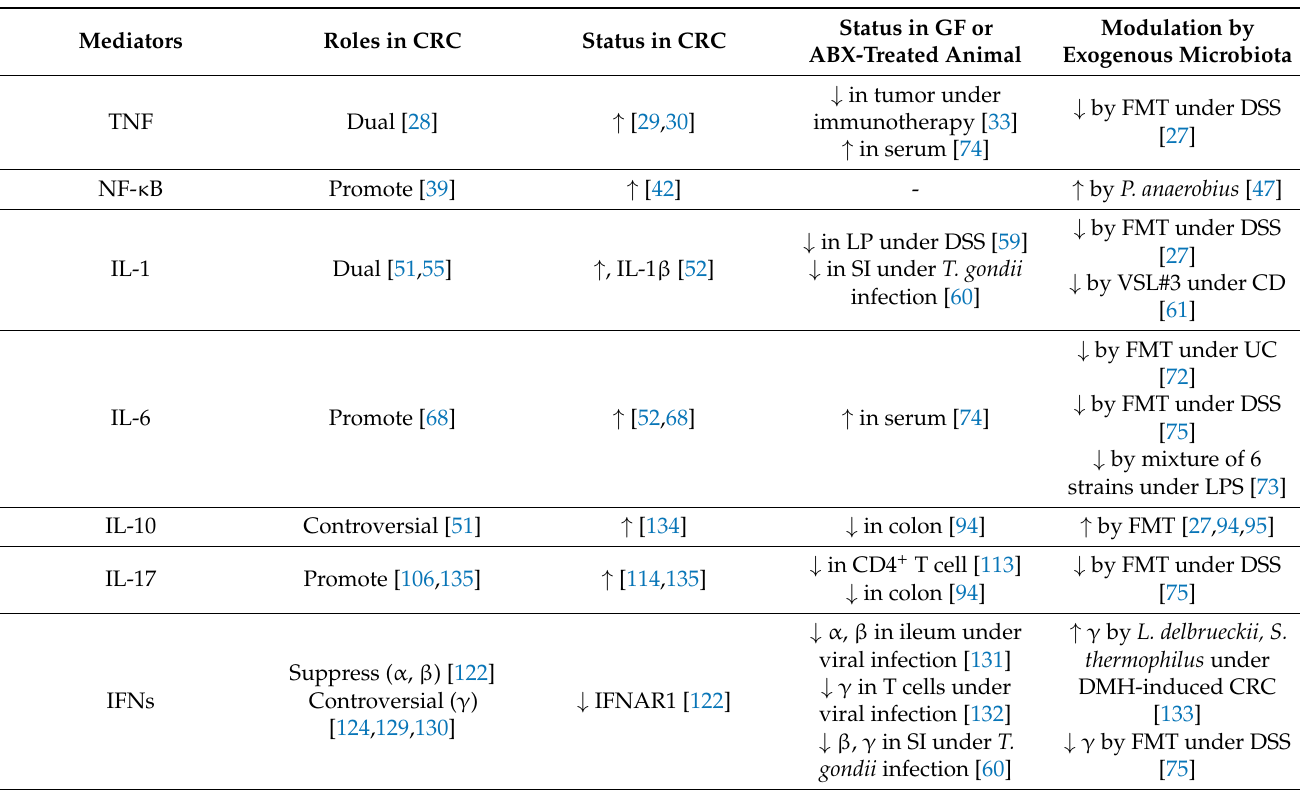
Table 1. Correlation between inflammatory mediators, CRC, and gut